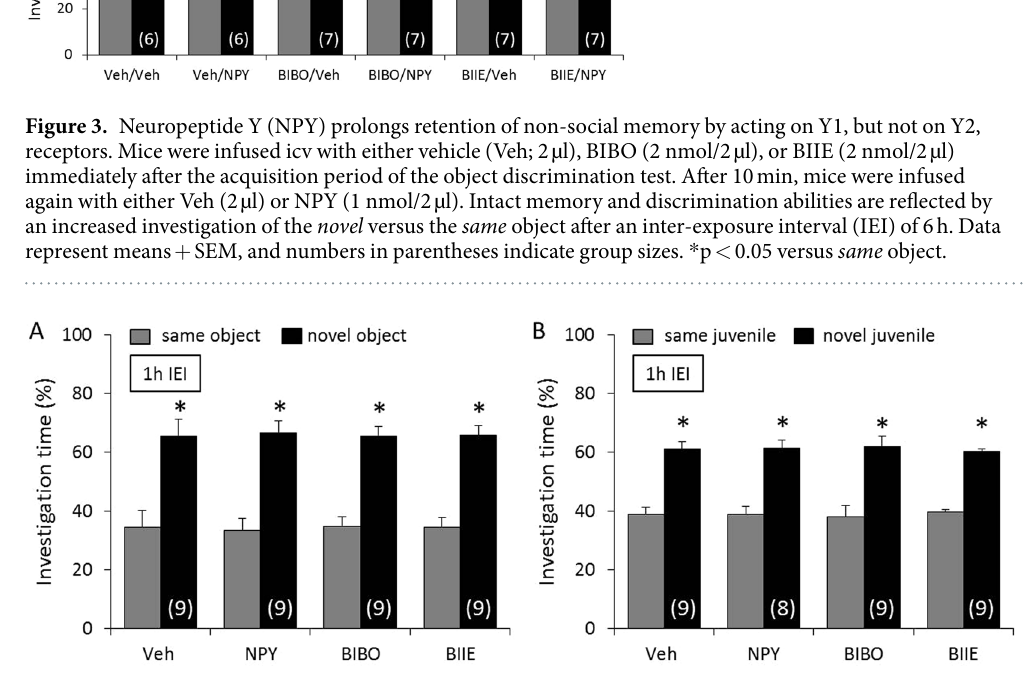
Figure 4. Neuropeptide Y (NPY) neurotransmission is not necessary for non-social and social memory acquisition. Mice were infused icv with either vehicle (Veh; 2 µ l), NPY (1 nmol/2 µ l), BIBO (2 nmol/2 µ l), or BIIE (2 nmol/2 µ l) 10 min before the acquisition period of the object ( A ) and social ( B ) discrimination test, respectively. Intact memory and discrimination abilities are reflected by an increased investigation of the novel versus the same stimulus after an inter-exposure interval (IEI) of 1 h. Data represent means + SEM, and numbers in parentheses indicate group sizes. * p < 0.05 versus same